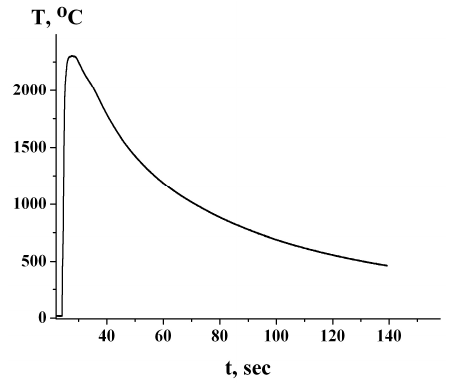
Figure 1. Combustion thermogram of the TiB 2 (75 wt %) + MgAl 2 O 4 (25 wt %) system. Studies on the microstructure of the composite blends based on TiB 2 with different MgAl 2 O 4